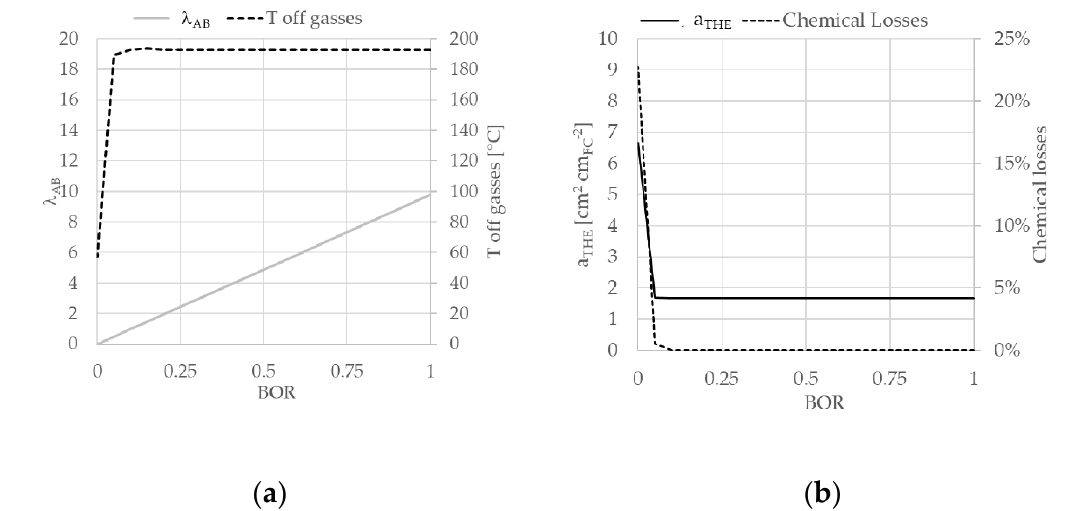
Figure 7. Graphs reporting results of BOR study results: λ AB and T off-gases ( a ) and A THE and chemical losses ( b ).